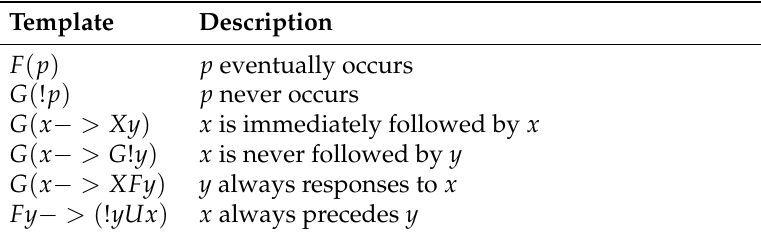
Table 1. A part of predefined LTL property